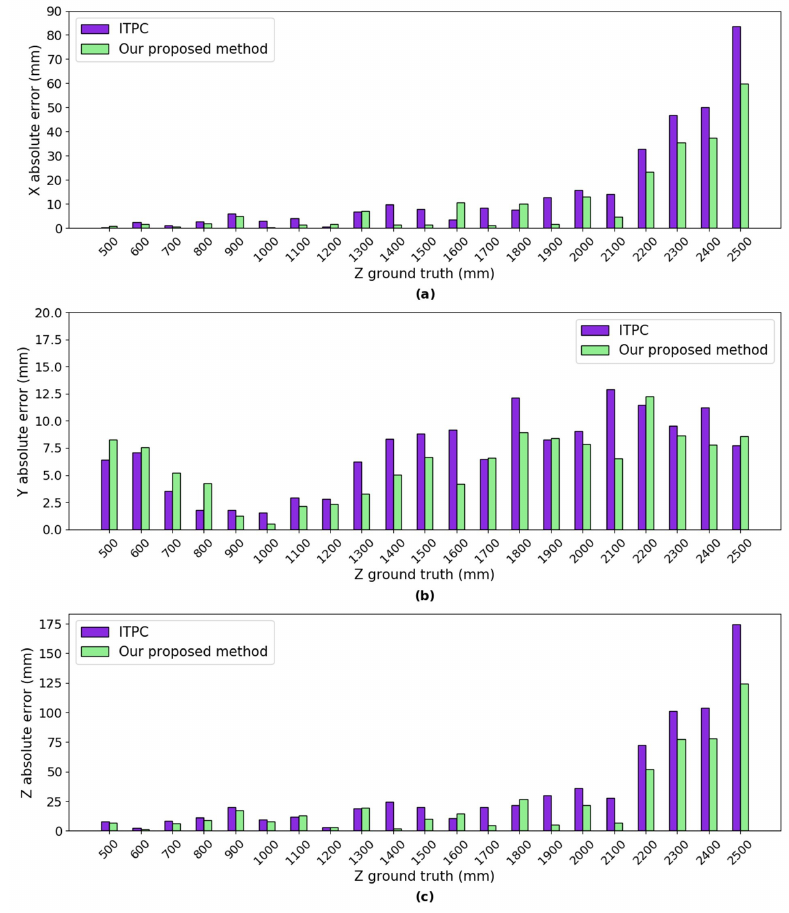
Figure 10. The absolute error of the mean of the estimated 3D coordinates using our proposed method and ITPC method w.r.t ground truth respectively. ( a ) absolute error in X axis; ( b ) absolute error in Y axis; and, ( c ) absolute error in Z